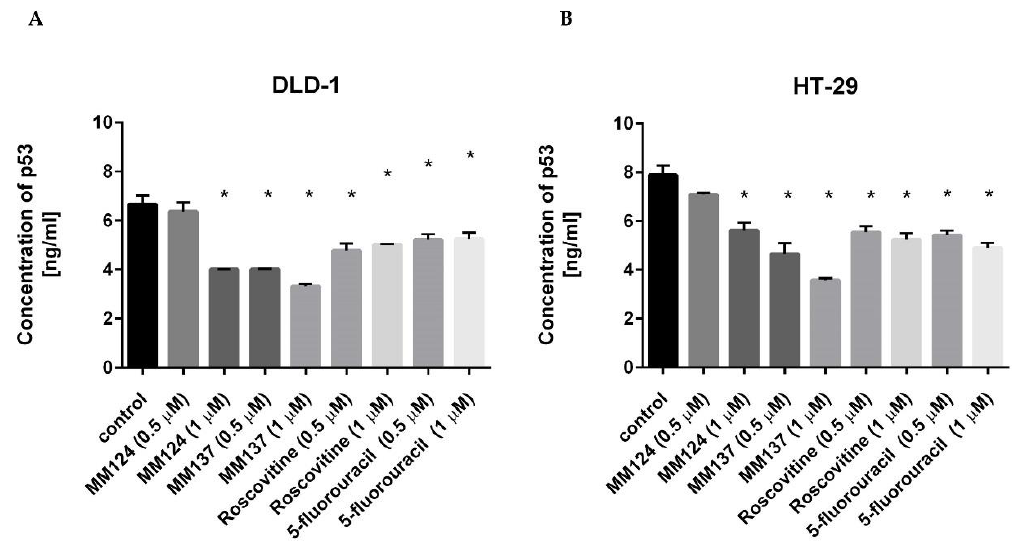
Figure 7. Concentration of p53 in DLD-1 ( A ) and HT-29 ( B ) human colorectal cancer cells after 24 h incubation with novel 7-methyl-5-phenyl-pyrazolo[4,3- e ]tetrazolo[4,5- b ][1,2,4]triazine sulfonamide derivatives (MM124, MM137), 5-fluorouracil, and roscovitine. Data is presented as mean ± SD from three independent experiments done in duplicate. * p < 0.05 vs. control group.